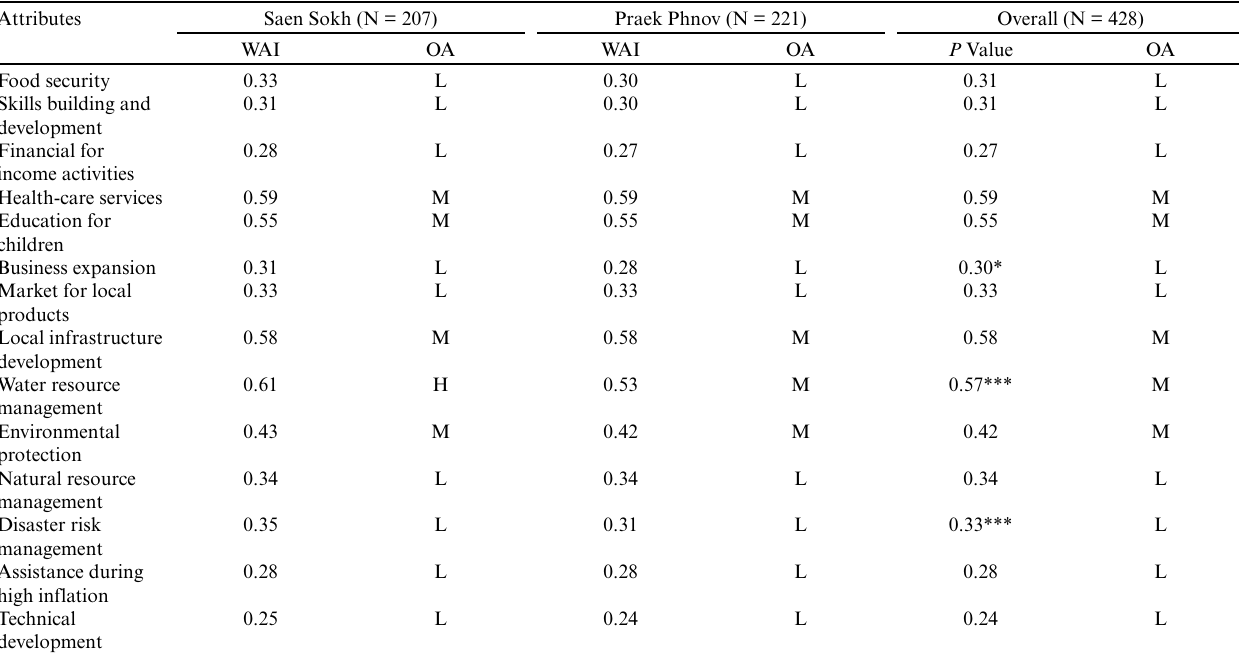
Table 6 . Perceptions on the level of external support for urban communities in improving their adaptive capacity. Attributes Food